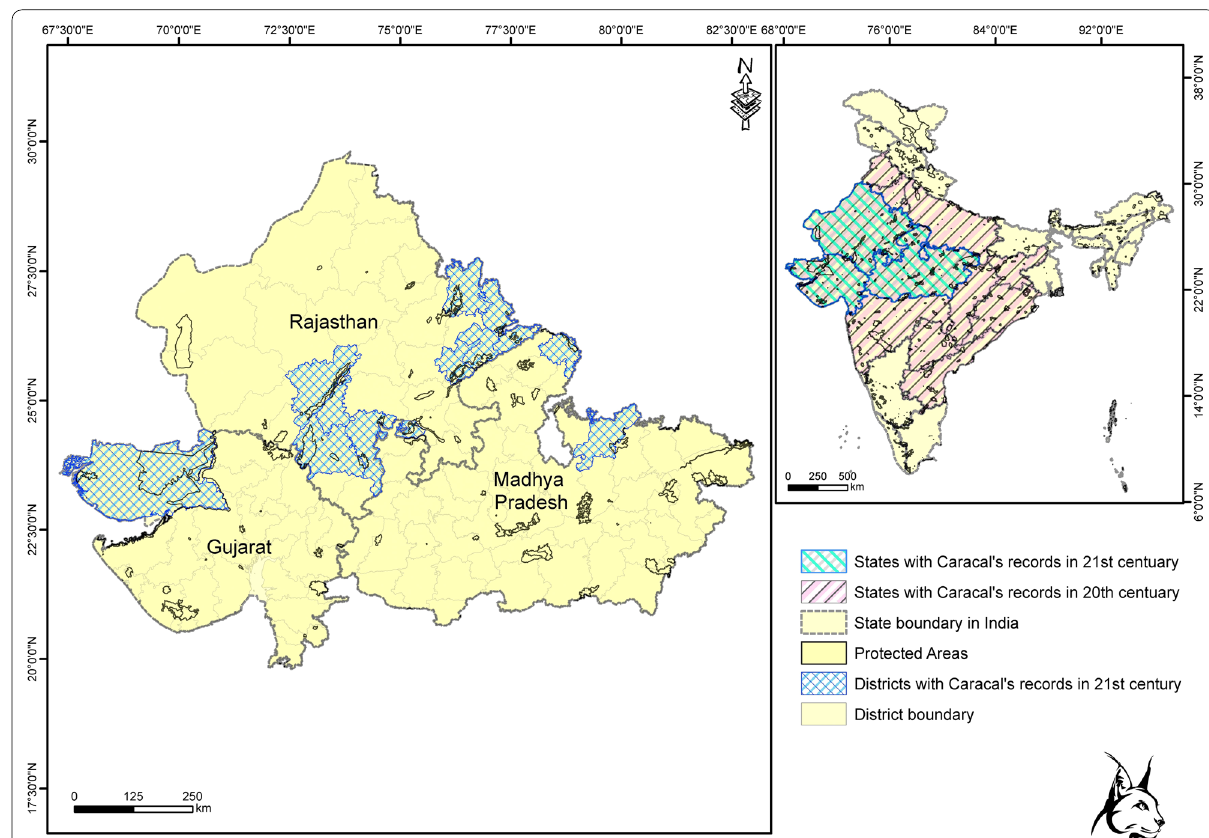
Fig. 1 Map depicting the states and districts with historical (20th century) and present (21st century) reported distribution ranges of